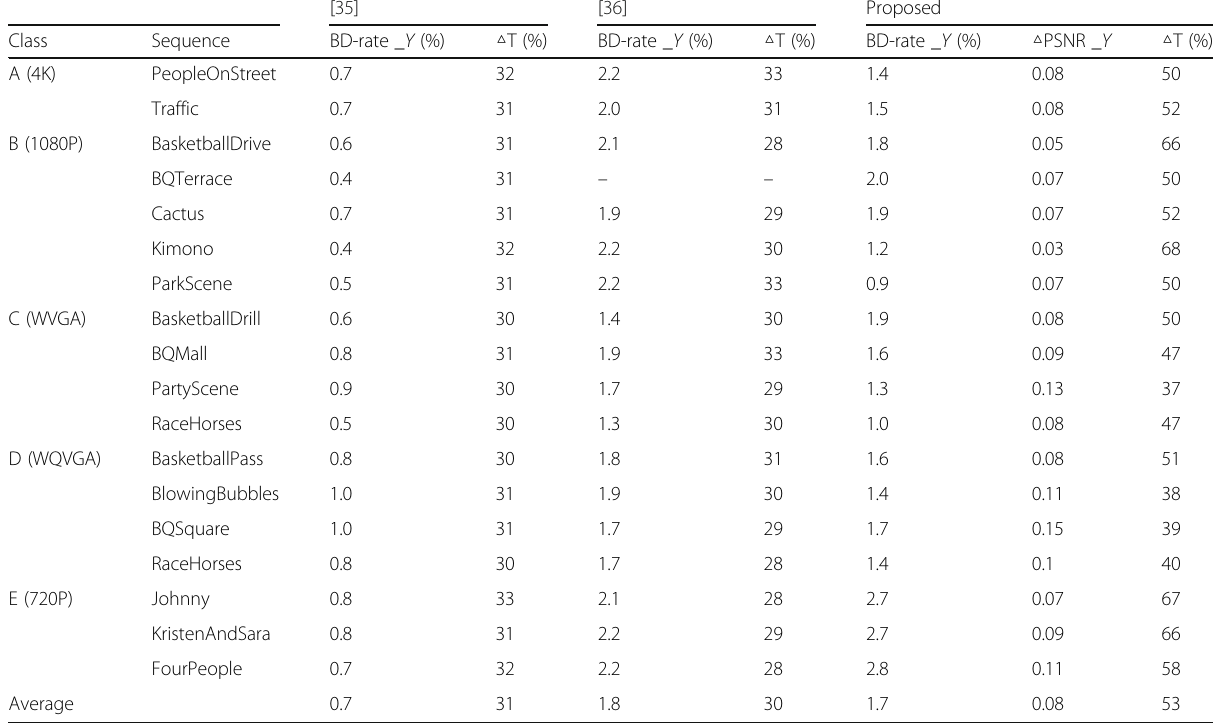
Table 5 Experiment results of our proposed algorithm and reference [35,